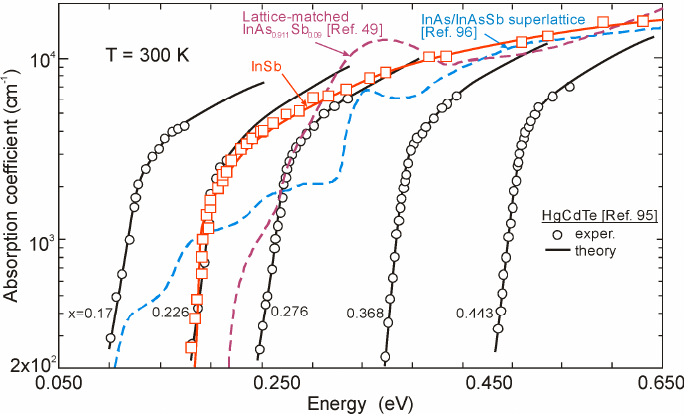
Figure 20. Absorption spectra for InAs 0.30 Sb 0.70 grown on GaAs substrates at 300 and 77 K with electron concentrations ( a ) 10 17 cm − 3 and ( b ) 2 × 10 18 cm − 3 . Solid lines present theoretical fitting (after [93]). Comparable values of absorption coefficients for bulk HgCdTe [94,95] and InAsSb [49,96] are